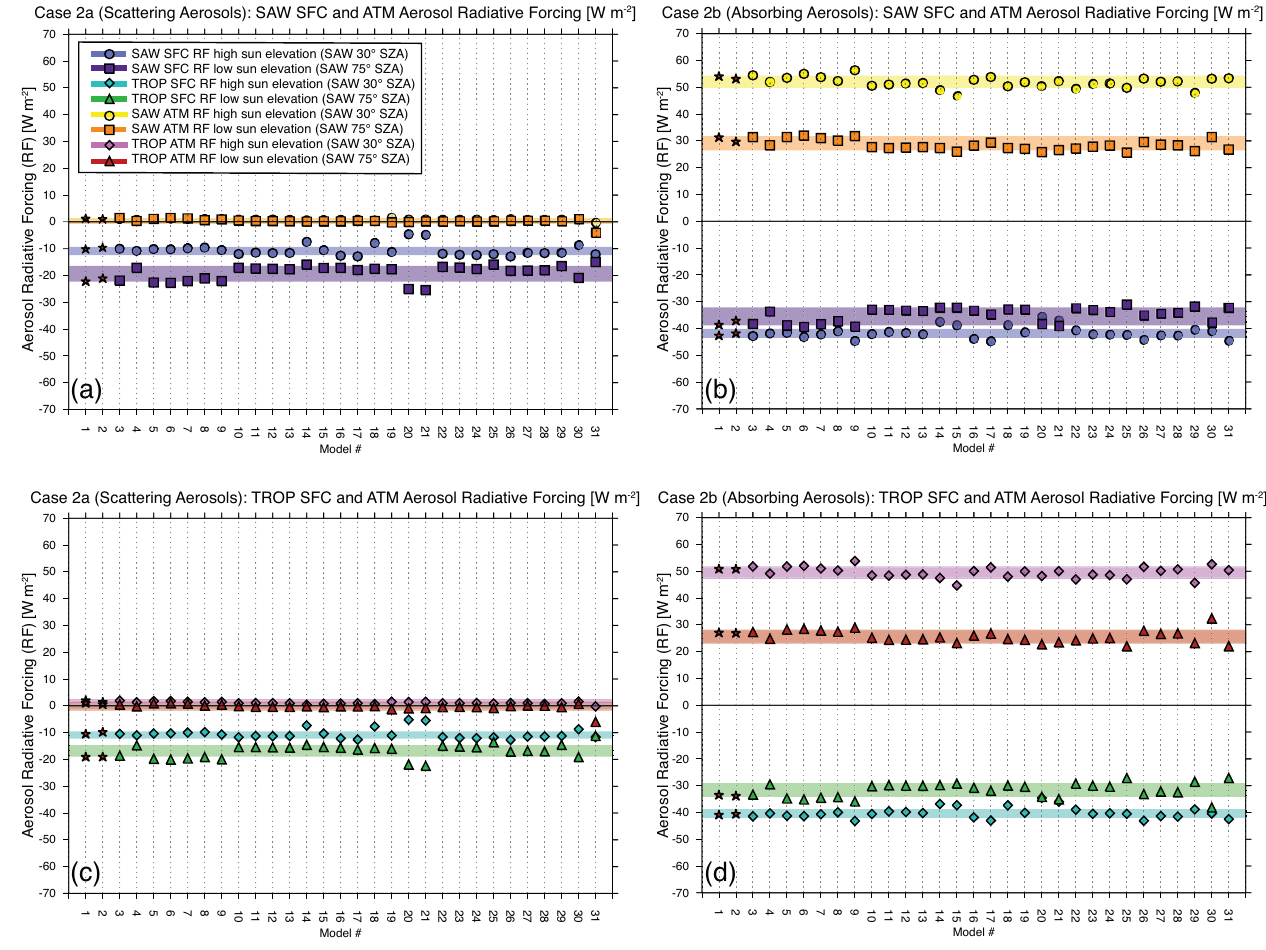
Fig. 5. Summary of results for surface and atmospheric aerosol radiative forcing (SFC and ATM RF) in Wm − 2 : (a) Case 2a (Scattering Aerosols) SAW, (b) Case 2b (Absorbing Aerosols) SAW, (c) Case 2a (Scattering Aerosols) TROP, and (d) Case 2b (Absorbing Aerosols) TROP. Line-by-line results (stars) and non-LBL results (non-stars) are given as a function of Model # (Table 1). Shading represents the greater of ± 1 standard deviation from the LBL or non-LBL mean. RF was calculated from Eq. (2) using normalized flux results that were scaled by the broadband TOA downwards fluxes given in Fig. 2. The ATM forcing is calculated as a residual from the TOA and SFC RF (i.e. ATM RF=TOA RF − SFC